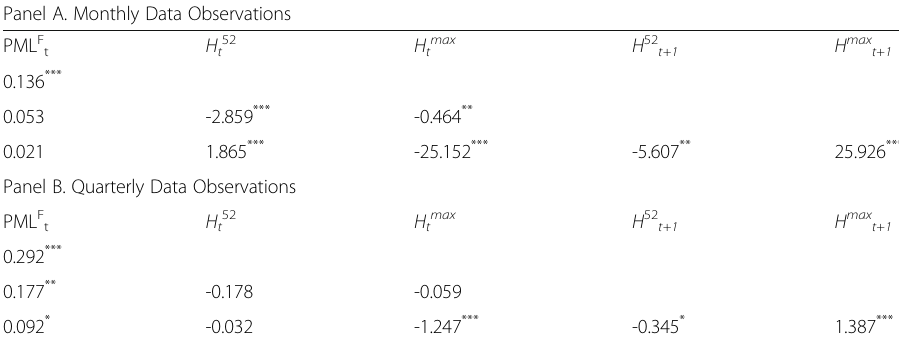
Table 15 Regression with 52-week High and Historical High Controlled Panel A. Monthly Data Observations